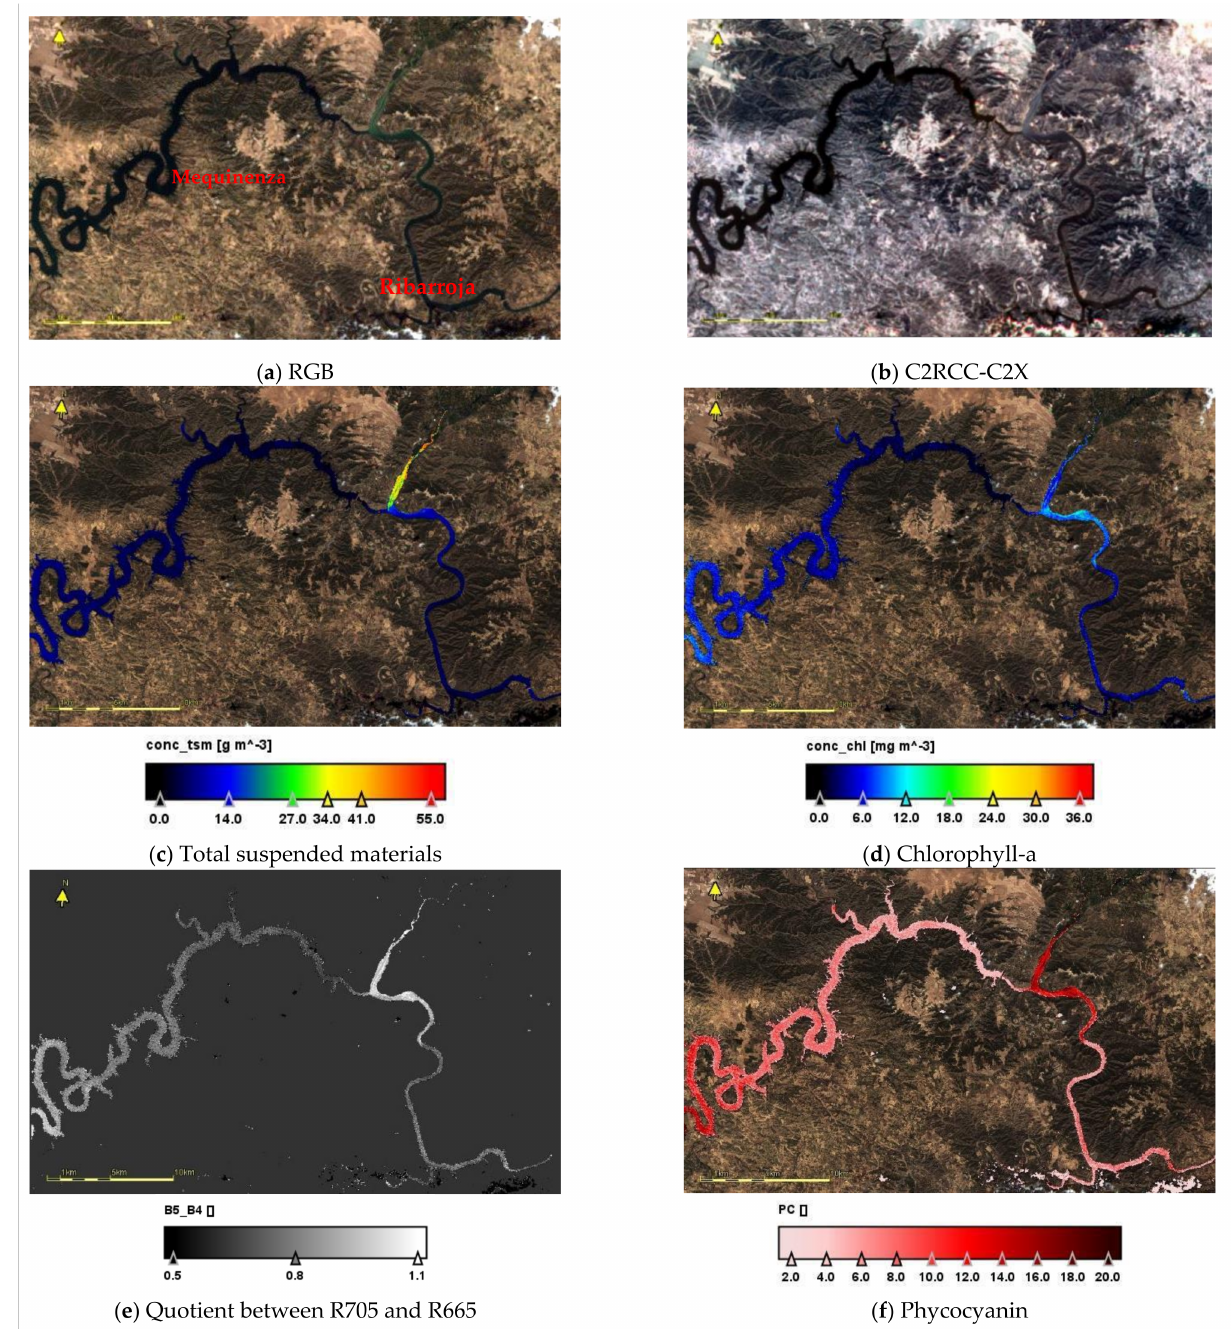
Figure 6. Example of thematic maps processing. The image of the lower Ebro in summer 2018: Mequinenza and Ribarroja reservoirs. ( a ) RGB map; ( b ) RGB image with C2X atmospheric correction; ( c ) map of total suspended matter automatic product; ( d ) map of Chl-a automatic product; ( e ) map of PC in gray scale applying the R705/R665 algorithm; ( f ) PC ( µ g/L) in its corresponding